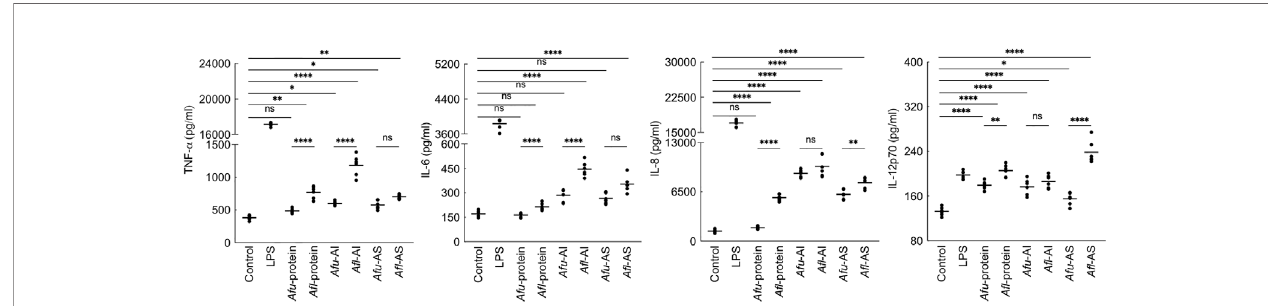
FIGURE 6 | Cytokine induction by the conidial cell wall components of the two Aspergillus species. Human monocyte-derived macrophages obtained by seeding 2x10 6 PMBCs per well were co-incubated with conidial cell wall alkali-insoluble (AI), soluble (AS) fractions (10 m g per well), or conidial formic acid extracts (protein; 1 m g per well) in RPMI medium at 37°C in CO 2 incubator for 20 h. Following, the supernatants were collected for cytokine quanti fi cation (macrophages obtained from three heathy donors and two technical replicate-data are presented; *p < 0.05, **p < 0.01, ***p < 0.005 and ***p < 0.0005; ns – not signi fi cant, bar – median, Afu: A. fumigatus and A fl : A. fl avus ).